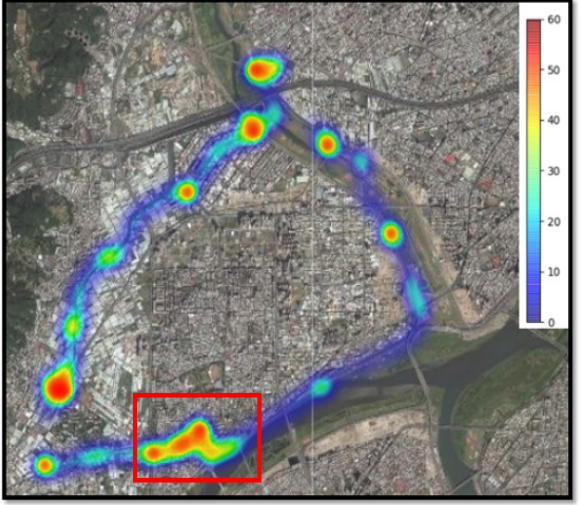
Figure 23. Prediction results for 07:30 P.M. on 15 February 2019.